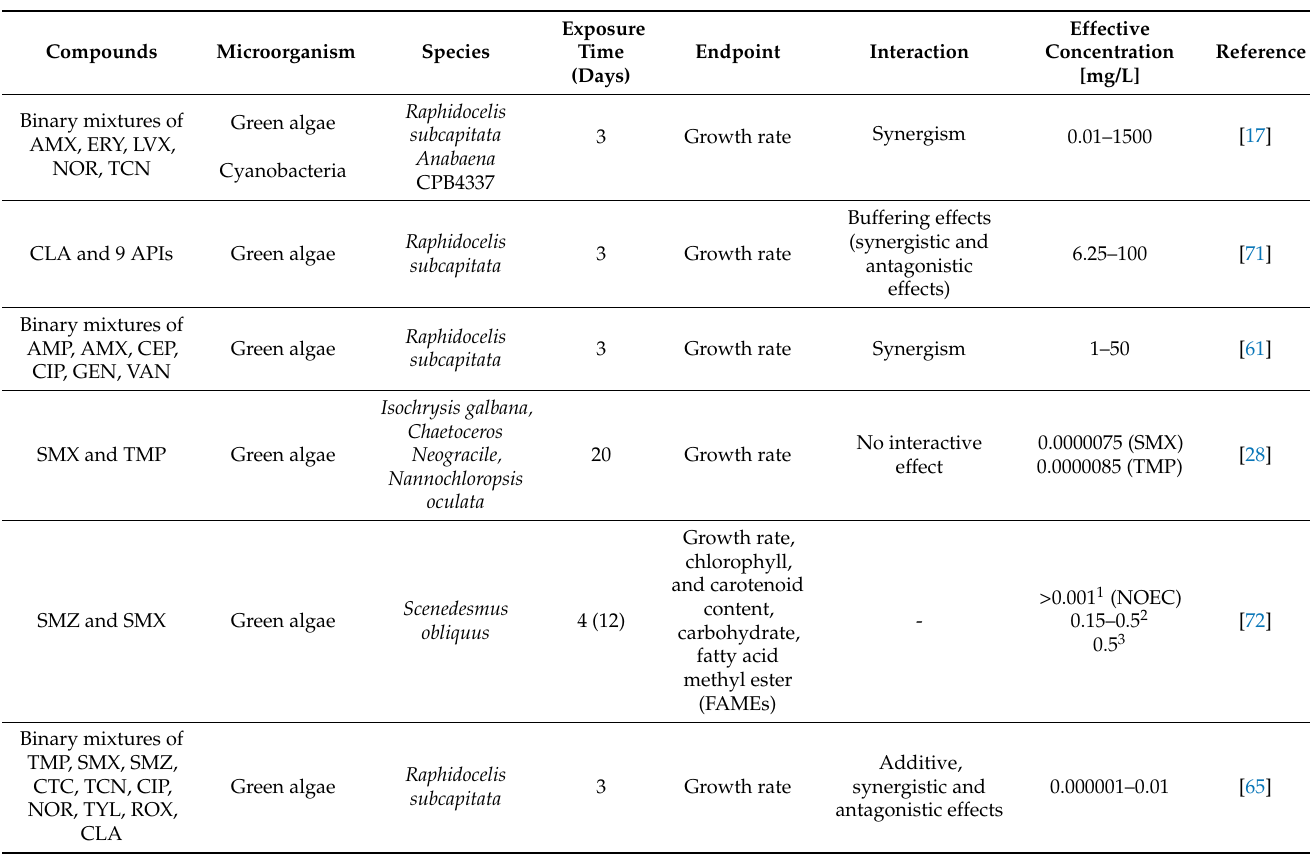
Table 1. The summary of available toxicity data on mixtures of antibiotics including other pharmaceuticals and